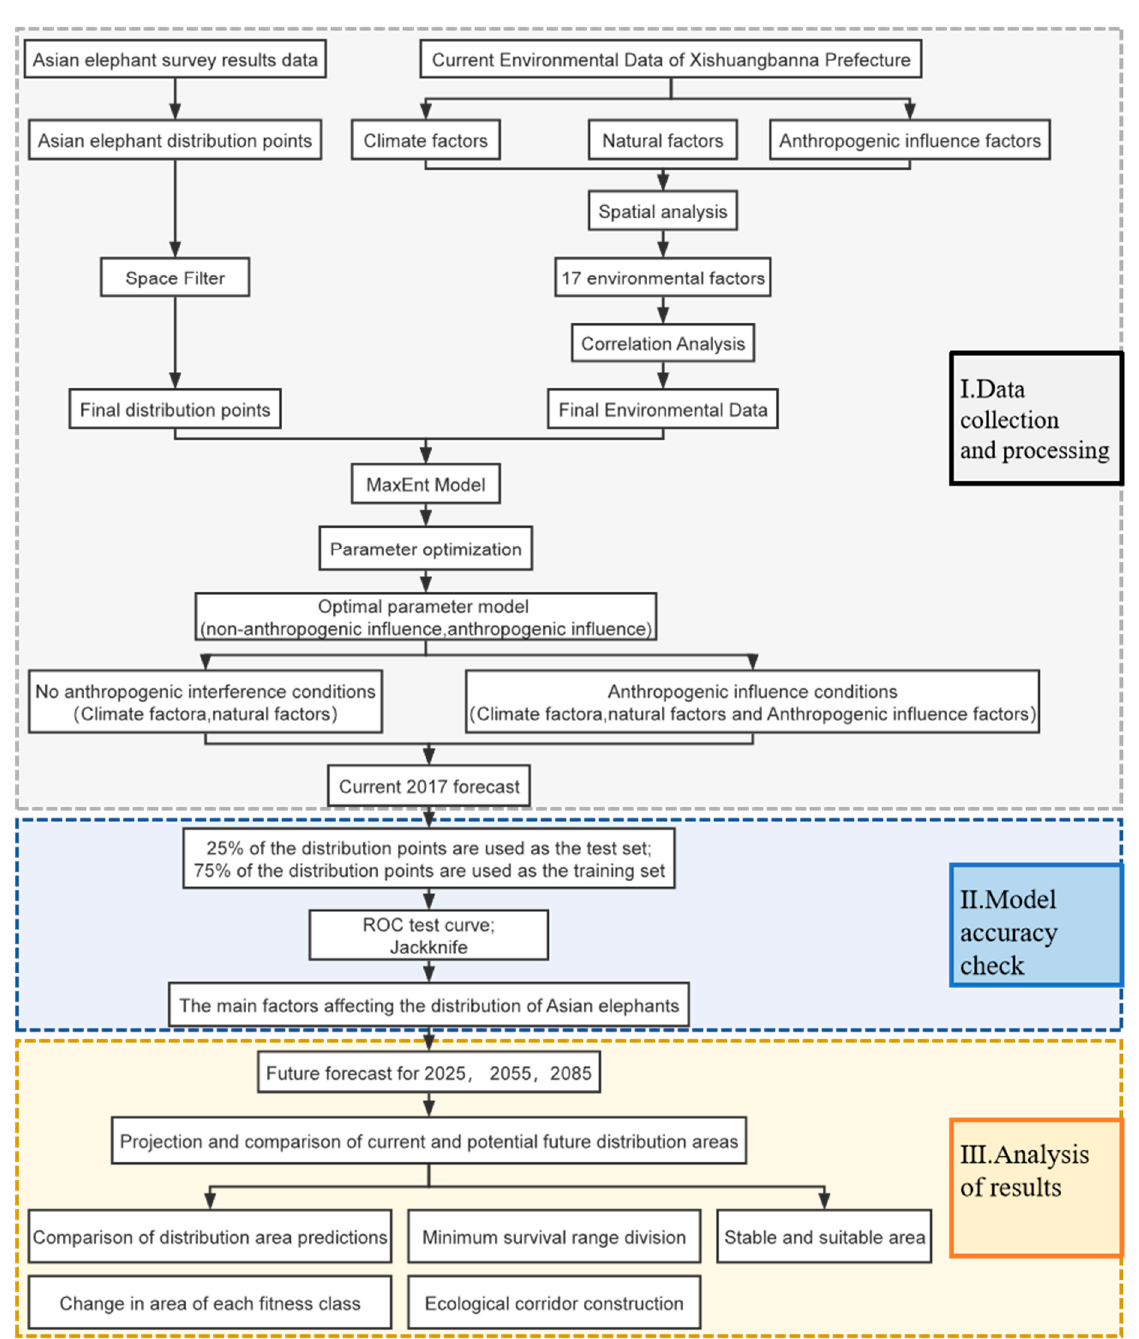
Figure 1. Research